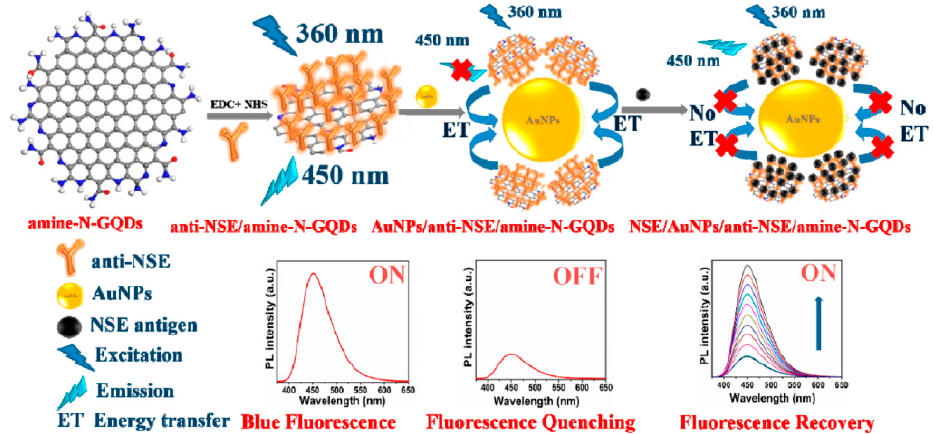
Figure 4. Mechanism of the anti-NSE/amine-N-GQDs@AuNP biosensor for small cell lung cancer biomarker detection. Reprinted with permission from ACS Applied Bio Materials, ref. [39]. Copyright (2020), American Chemical Society.